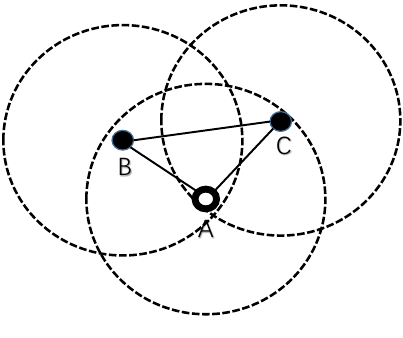
Figure 3. Multi-copy